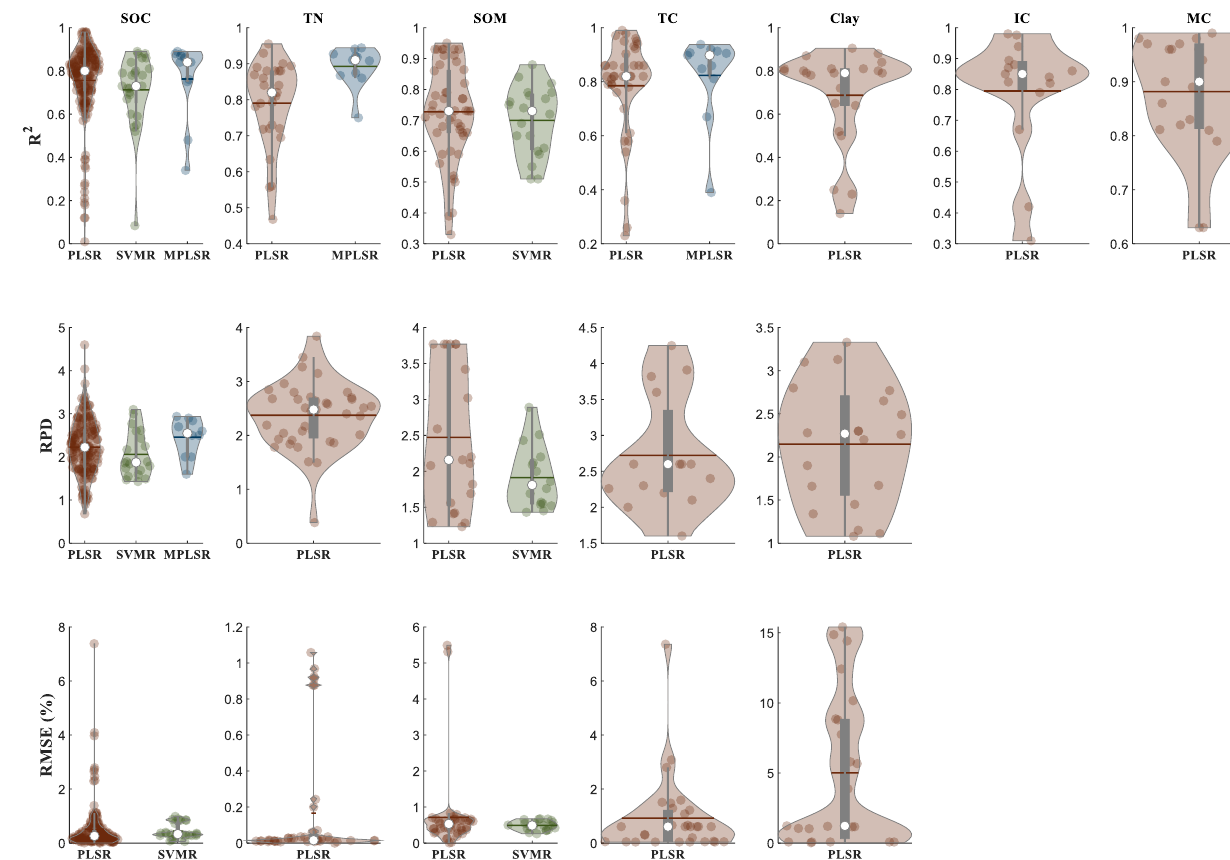
Figure 8. Statistical measures for soil properties predicted by different regression methods .